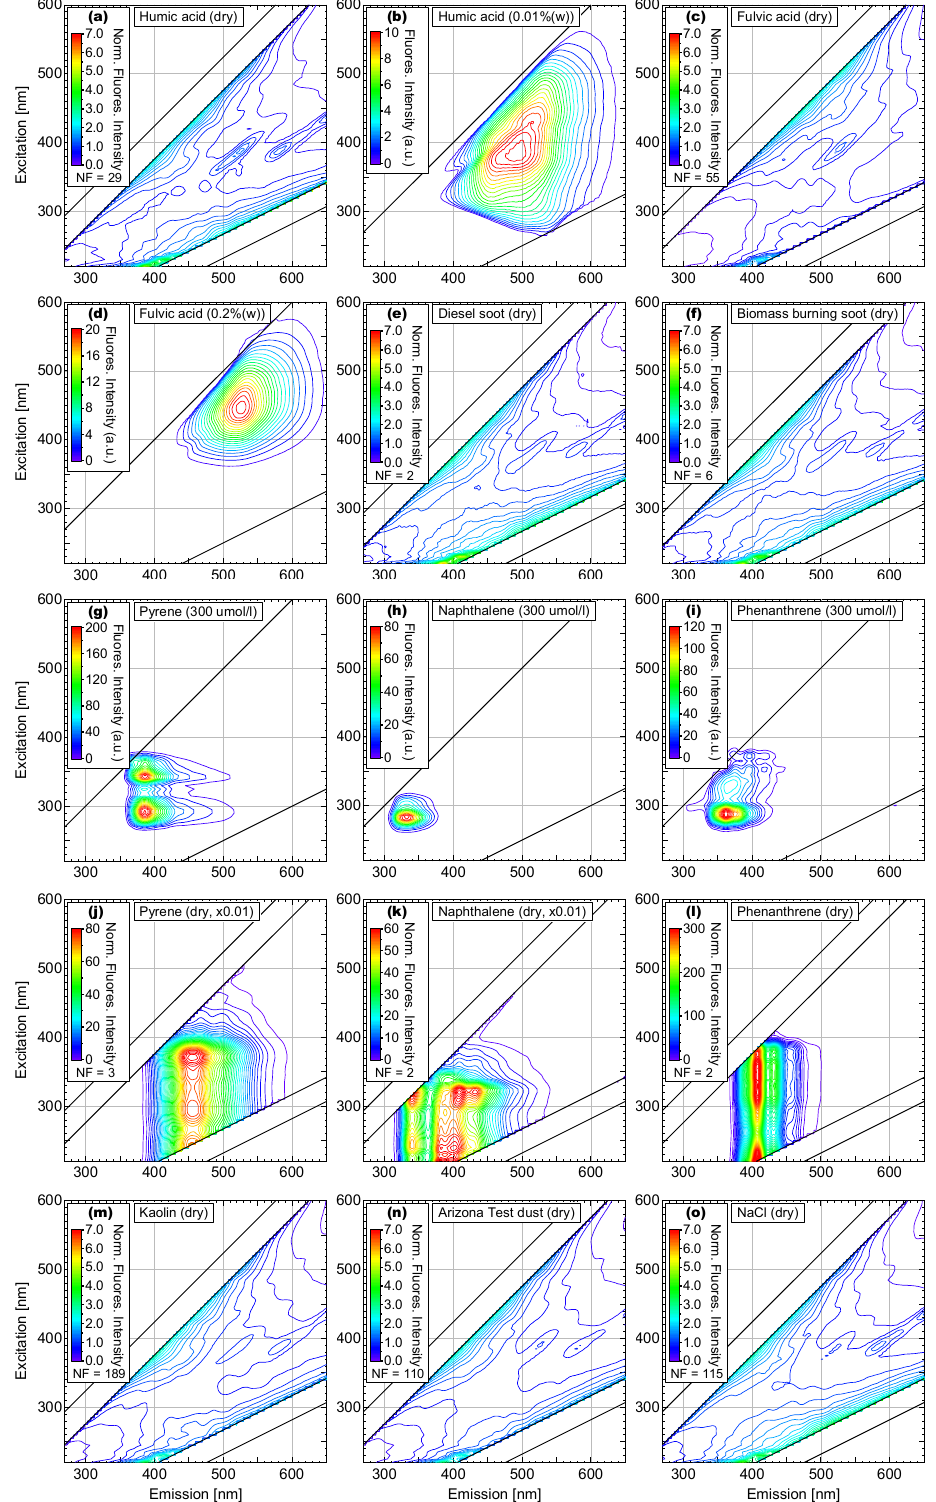
Fig. 5. Normalized EEM contour profiles for selected interferences in solid state and/or solution. Intensity color scale has been adjusted to intensity of individual components. All EEMs are normalized as discussed in text (Sect. 3.2). Normalization factor (NF) is reported for each solid-state sample. Lower NF indicates higher fluorescence